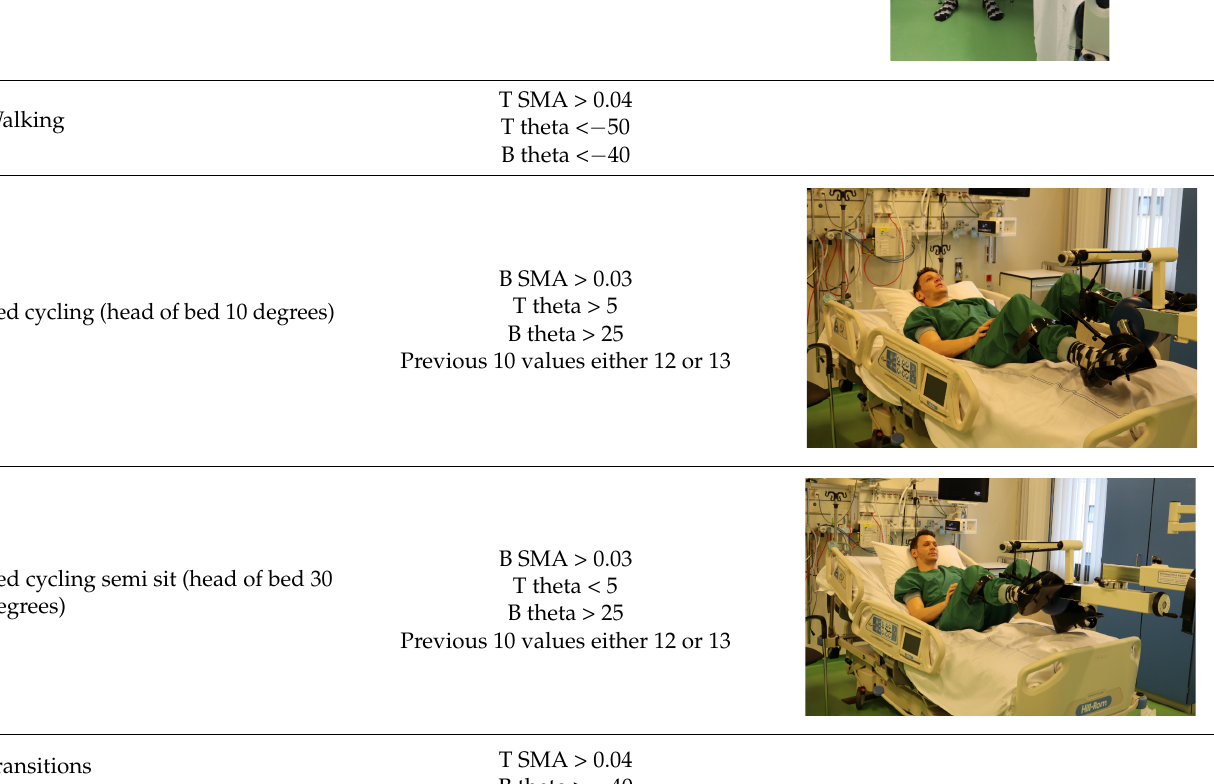
14. Transitions T SMA > 0.04 B theta > − 40 Abbreviations: T, accelerometer placed at het thorax, B, accelerometer placed at the leg, SMA, signal magnitude area.